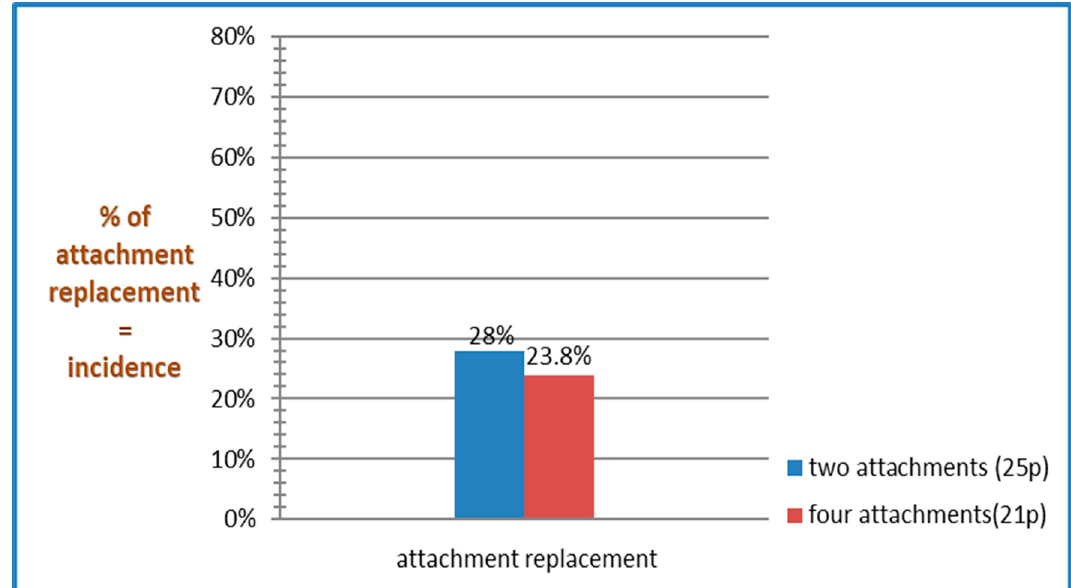
Figure 2. statistical analysis of prosthetic aftercare; incidence of attachment replacement. Figure 2. Statistical analysis of prosthetic aftercare; incidence of attachment The independent variables (group A vs. group B, respectively) including age (mean age in both groups—64 years, p = 0.915), gender (male/female—14/11 in group A vs. 9/12